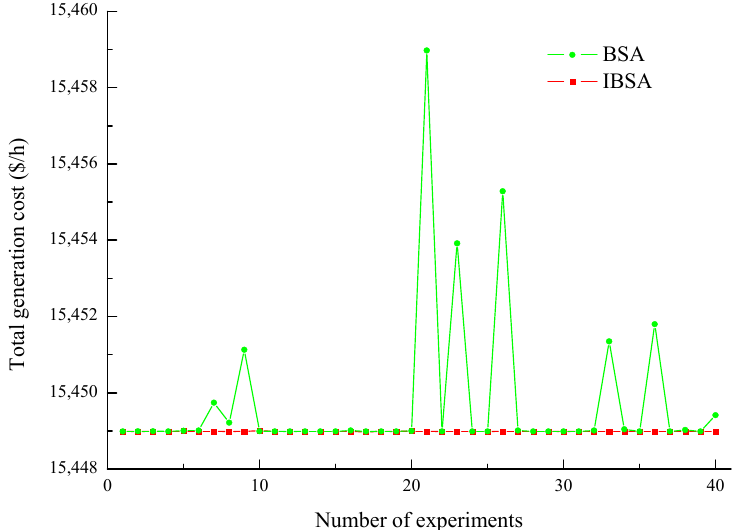
Figure 2. Distribution of results with BSA and IBSA in System 1.